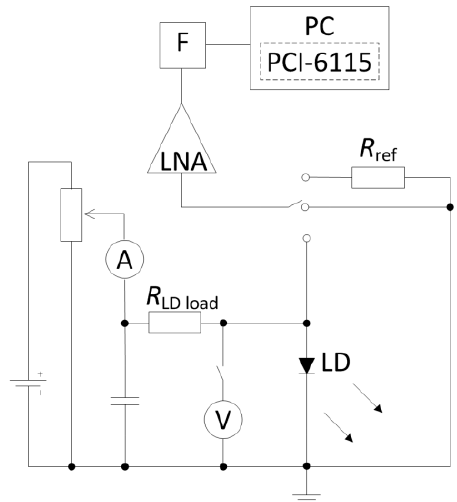
Figure 3. The noise measurement system: LD is the laser diode under investigation, R LD load is a load resistor, R ref is a reference resistor, LNA is a low-noise amplifier, F is a filter system, PC is a personal computer with PCI-6115 analogue-to-digital converter and fast Fourier transform (FFT)-based spectrum analyzer program.